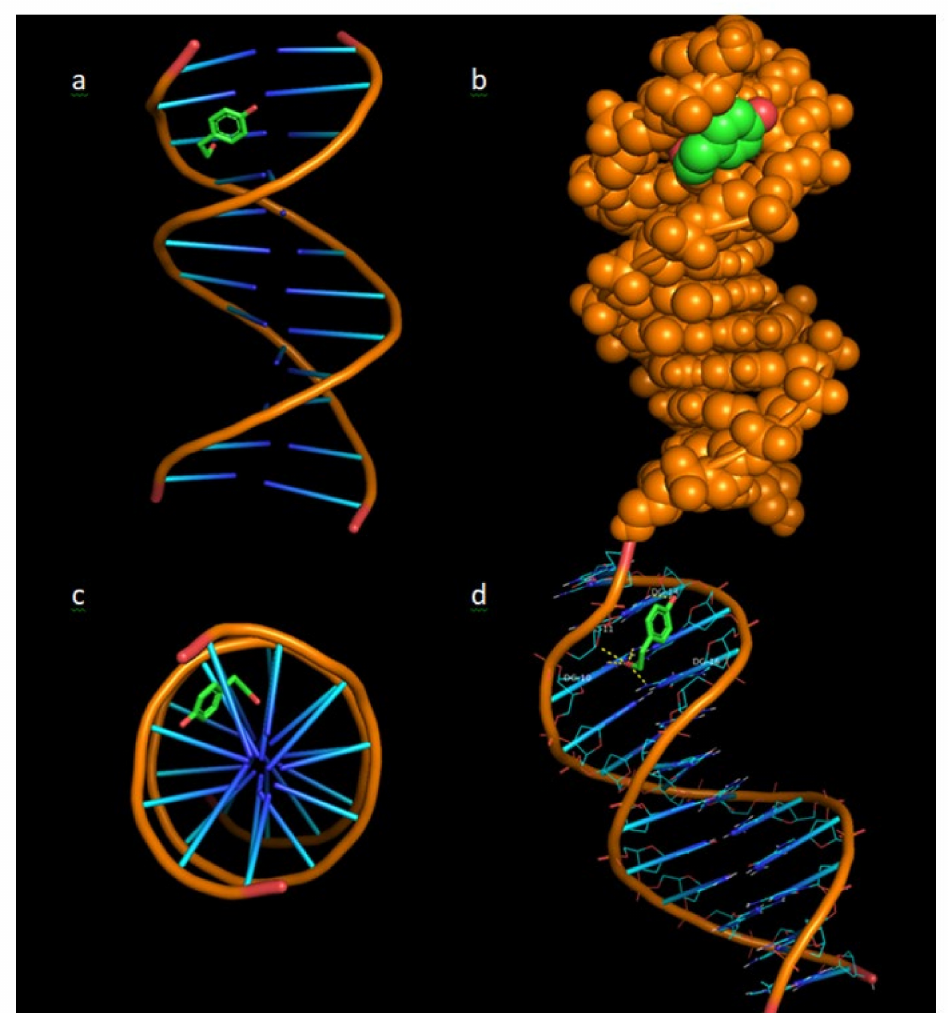
Figure 12. Binding architecture of tyrosol in the crystal structure of CT DNA (PDB:1bna) depicting its stabilisation in the binding cavity of minor groove of DNA. ( a ) DNA structure and tyrosol are illustrated as cartoons, ( b ) DNA structure and tyrosol are formed as spheres, ( c ) The docking pose from a view above the axis of the helix, ( d ) Nucleotides are rendered in line mode and the yellow dotted lines indicate hydrogen bonds between the docked molecule and the nucleotides of the binding pocket in the minor groove of